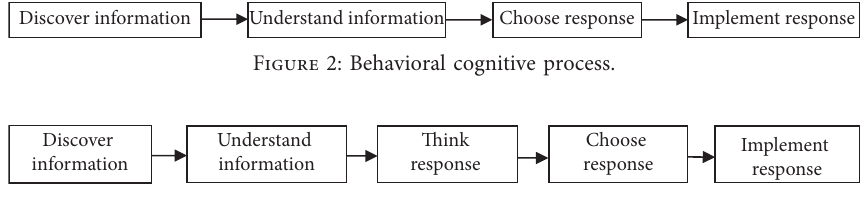
Figure 3: Five-link composition model of the behavioral cognitive